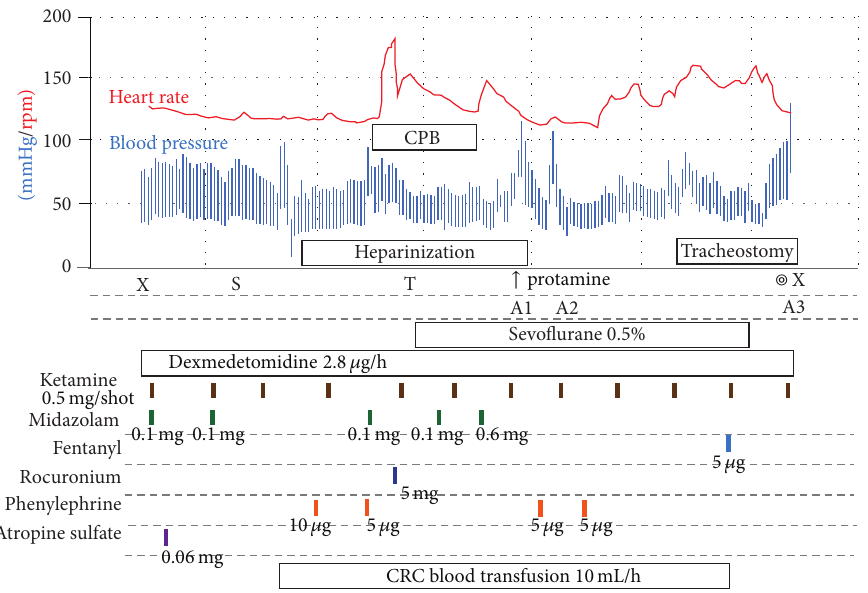
Figure 2: Time course of anesthesia management under extracorporeal cardiopulmonary support and the following tracheostomy. X: start and end of anesthesia management. S: start of surgery for extracorporeal cardiopulmonary support. T: tracheal intubation. Arterial blood gas data were measured at A1, A2, and A3. A1: pH, 7.46; PaCO 2 , 36.8 mmHg; PaO 2 , 240 mmHg; base excess, 2.4 mmol/L; and SaO 2 , 100%. A2: pH, 7.39; PaCO 2 , 46.8 mmHg; PaO 2 , 118mmHg; base excess, 2.8 mmol/L; and SaO 2 , 99%. A3: pH, 7.49; PaCO 2 , 33.3 mmHg; PaO 2 , 509 mmHg; base excess, 2.9 mmol/L; and SaO 2 ,